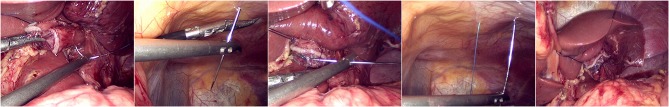
Esophageal left side suspension and fixation.